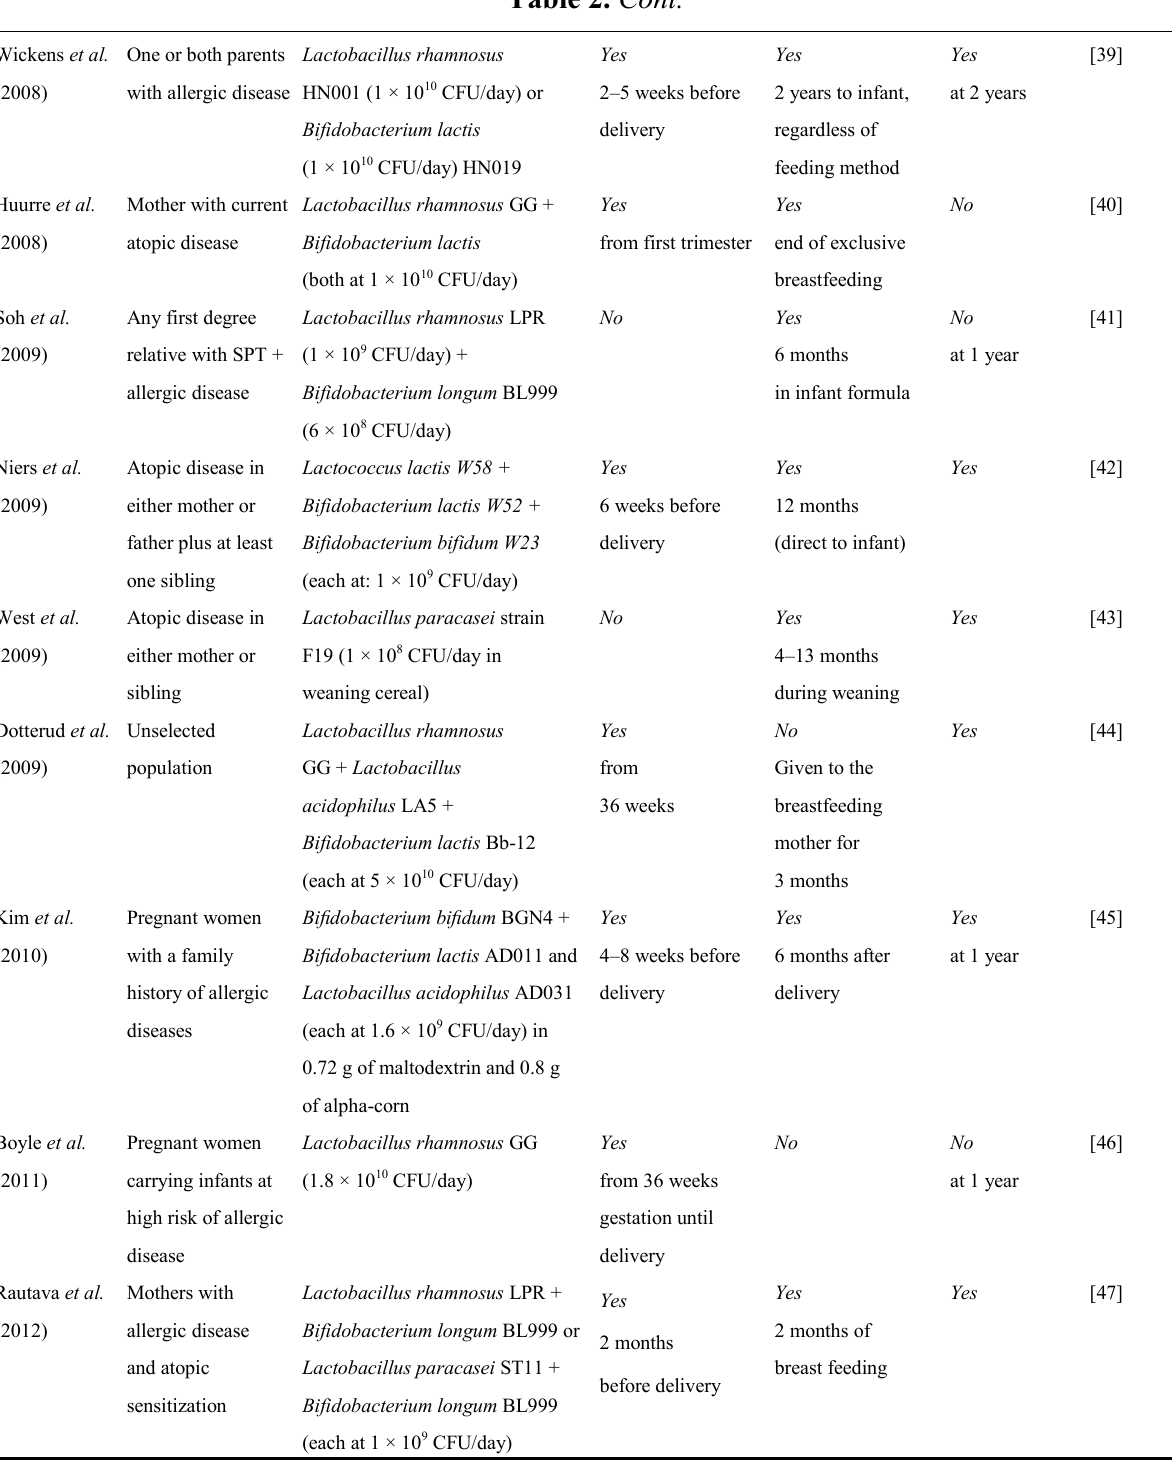
SPT: skin prick test; CFU: colony-forming